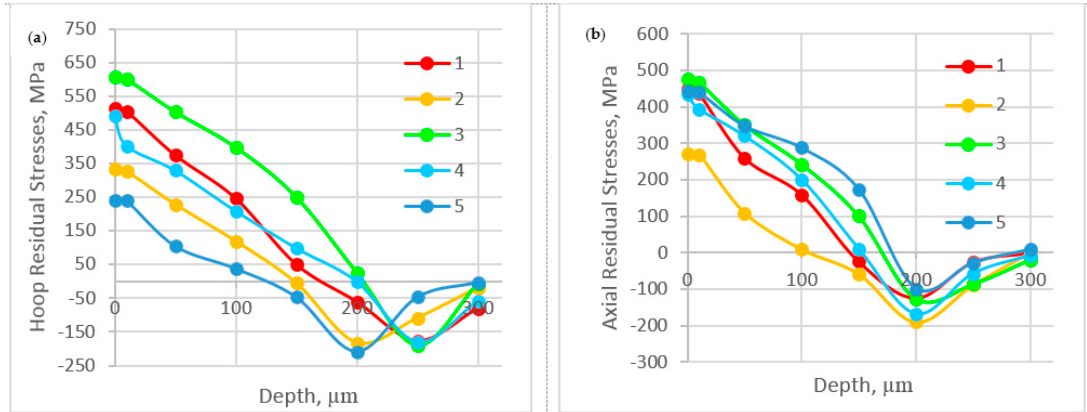
Figure 9. In depth residual stresses profiles for five selected points in the steady state zone in: ( a ) cutting direction; and ( b ) feed direction.